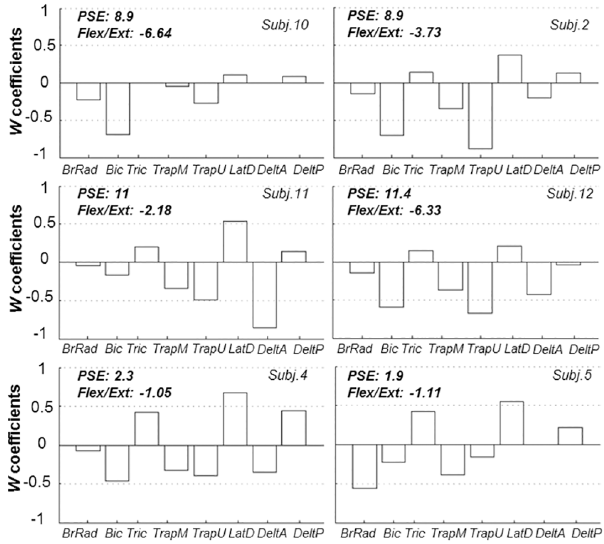
Fig 9. Individual distribution of muscular w coefficients and flexor/extensor ratio for pair of subjects with similar PSE. Each bar represents the w coefficient associated for each muscle. Coefficient value represent an estimate of the sensitivity of each muscle to be modulated by the changes in the external forces. Positive values correspond to joint extensor modulations in response to changes in the upward external force. Negative coefficients quantified the correspondence between joint flexor muscles and external force changes. Flex/Ext w coefficients ratio is a measure of the absolute relation between flexor and extensor joint